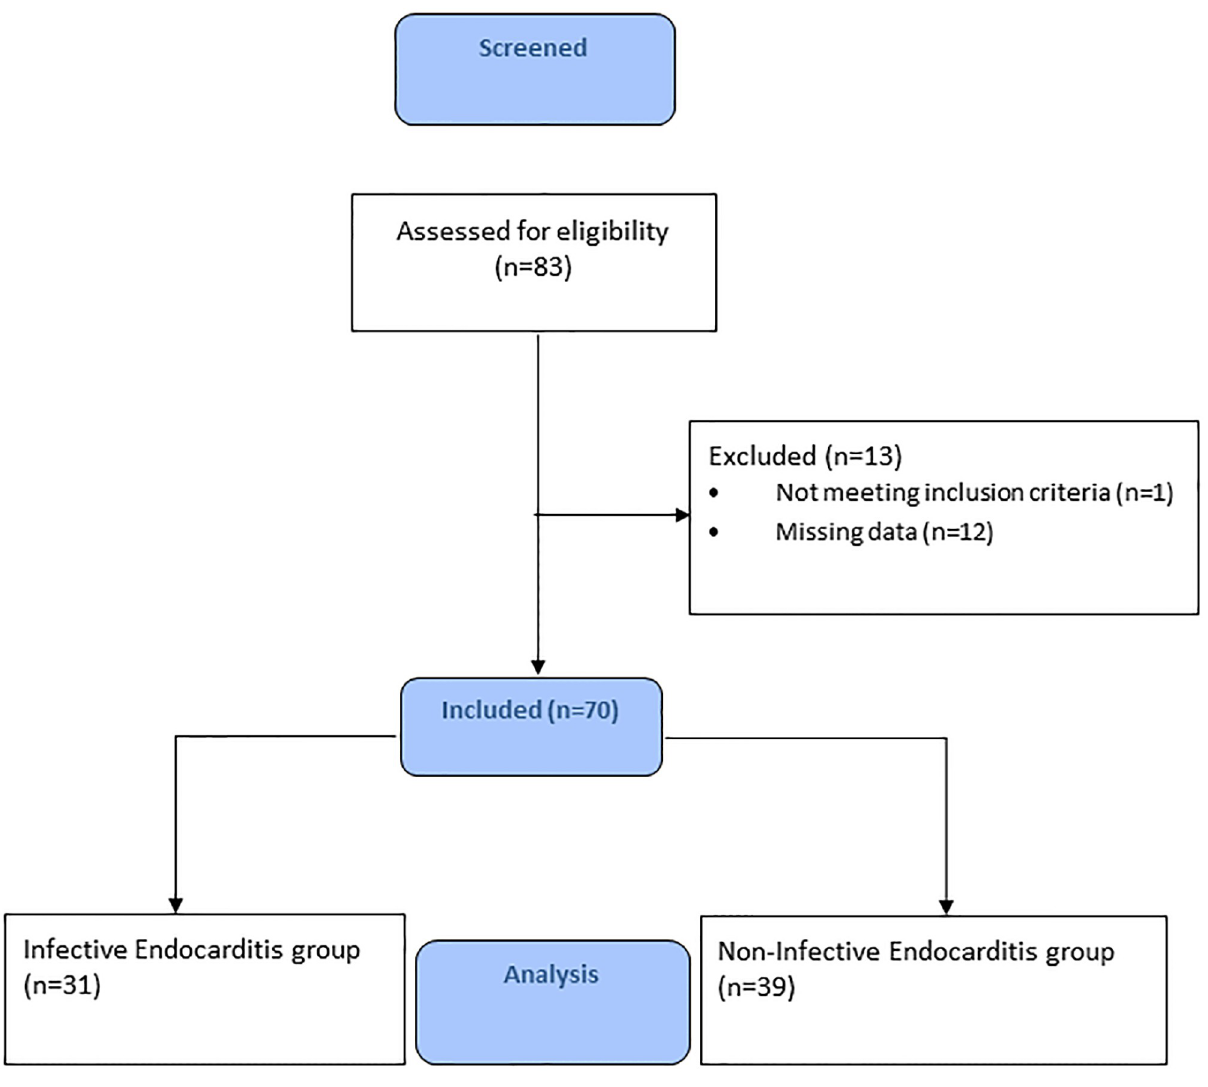
Fig 1. Flowchart of screening and